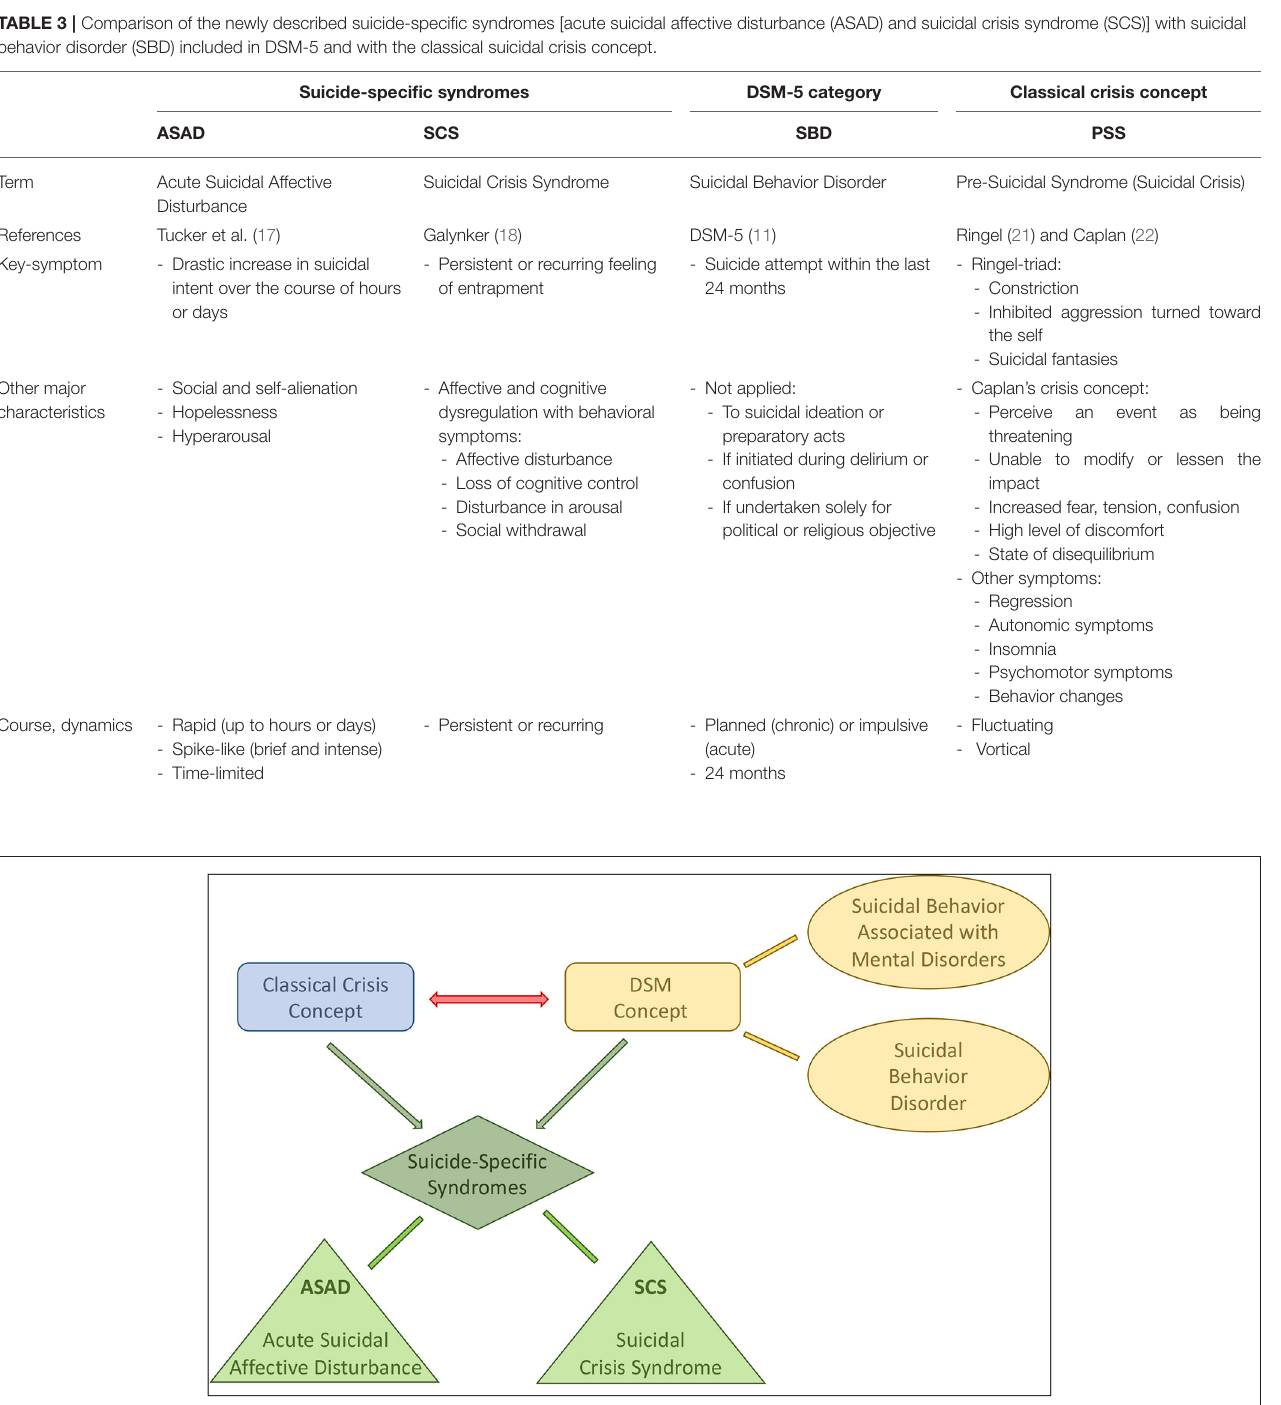
Frontiers in Psychiatry |